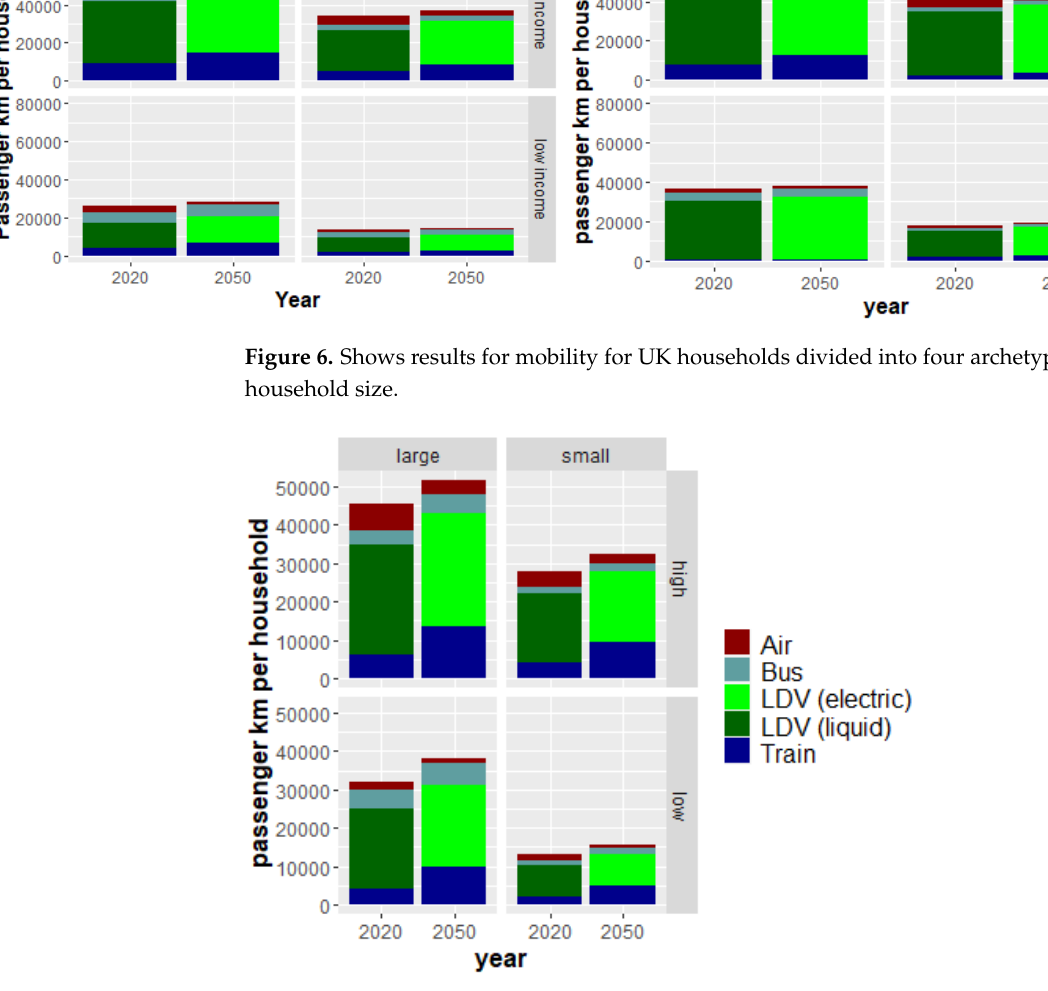
Figure 7. Mean distances travelled by four Swedish household archetypes, derived from ‘1.5C Total‘ scenario [16]. Large households > 2 people, high income > SEK 500,000 household